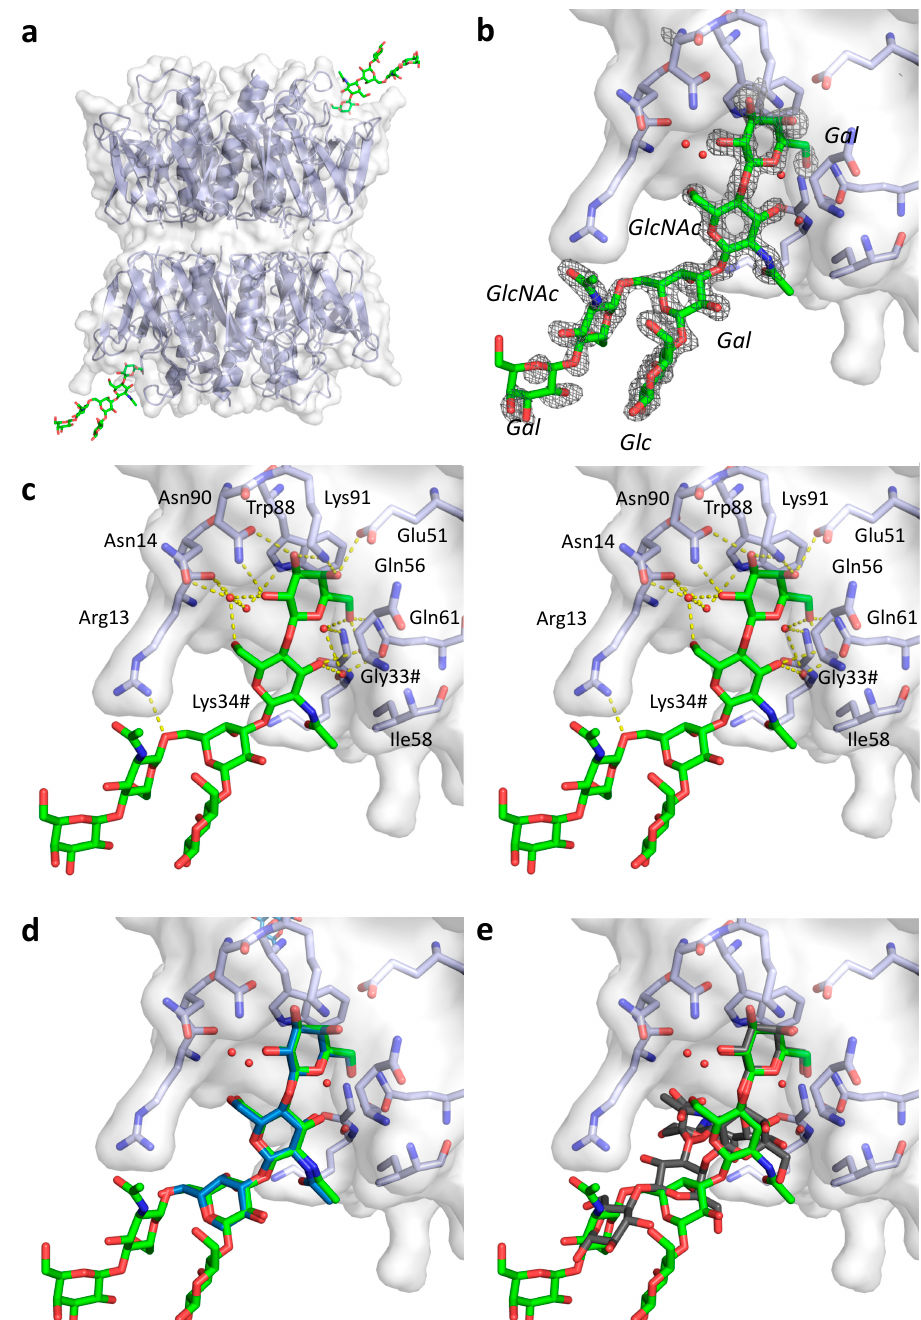
Figure 3. Structure of pLTB in complex with lacto- N -neohexaose (PDB ID: 6IAL, this work; LNnH shown in stick representation with green carbons). ( a ) Overview of the asymmetric unit, with two B-pentamers positioned “top-to-top” and two LNnH molecules bound. ( b ) Close-up view of the ligand binding site, with σ A –weighted F o - F c electron density map shown in grey mesh contoured at 3.0 σ , generated before placing the ligand. ( c ) Stereo-image of the binding site, with important residues labeled, H-bonding interactions shown as yellow dotted lines, and selected water molecules depicted as red spheres. Residues from the neighboring subunit are indicated by a hash (#). ( d ) Close-up view of the LNnH binding site superimposed with LNnT (blue) from structure 2XRS [10]. ( e ) Close-up view of the LNnH binding site superimposed with GM1 pentasaccharide (grey) from structure 2XRQ